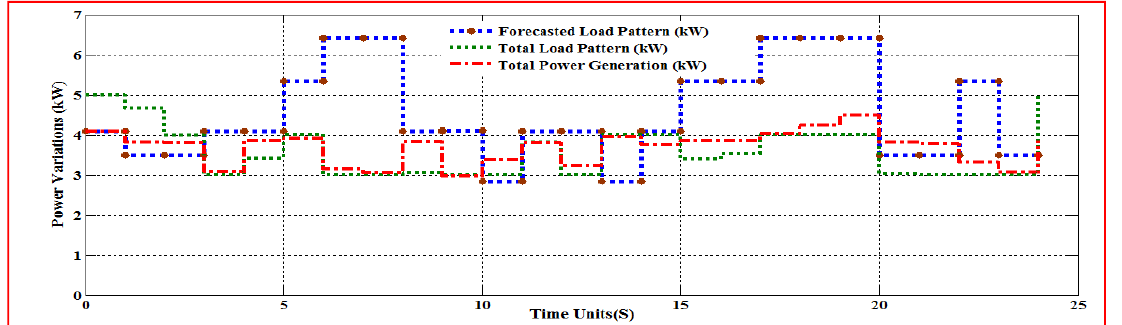
Figure 16. Simulation output of Load management by the proposed Controller.